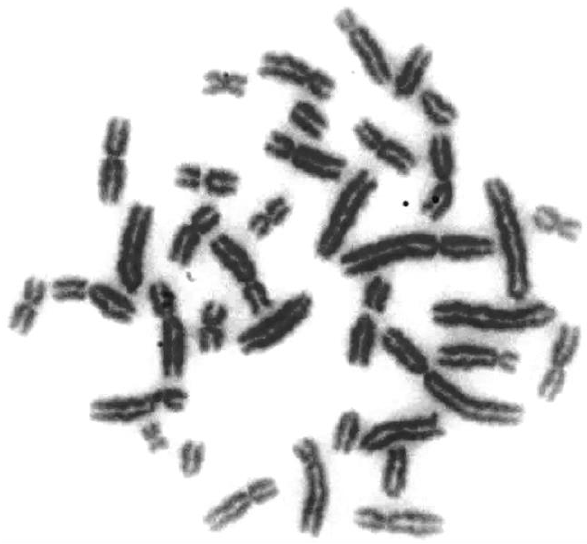
Figure 1. Metaphase chromosomes of boar with 38 XY karyotype-conventional Giemsa staining.